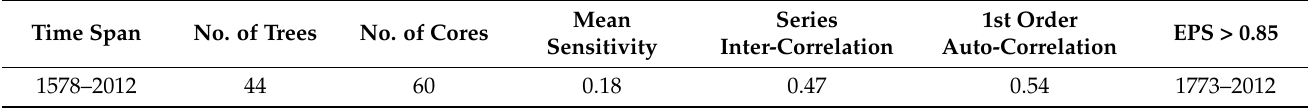
Table 1. Descriptive statistics of site chronology.